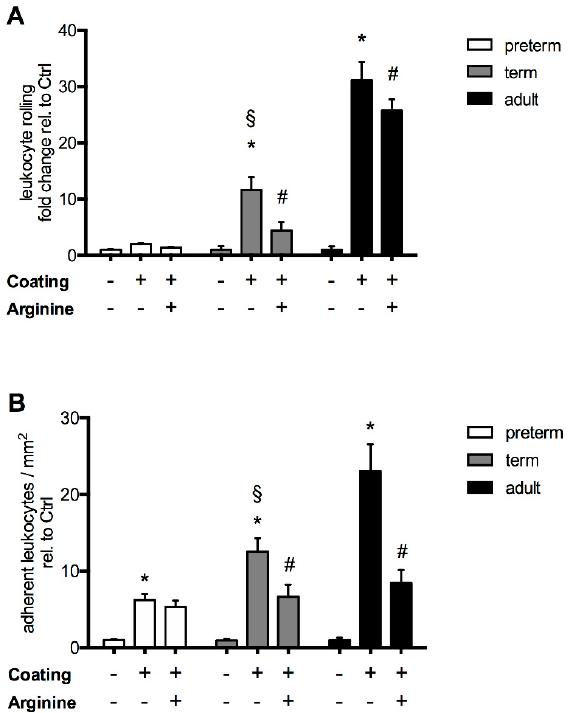
Figure 2. Leukocyte rolling and adhesion is decreased by L-arginine in term infants. Leukocyte rolling ( A ) and adhesion ( B ) of preterm and term infants and adults was analyzed in dynamic microflow chamber experiments. Neutrophil rolling and adhesion upon P-selectin, IL-8, and ICAM-1 coating was compared between the various age groups and to respective uncoated controls or cells that were incubated in 10 µ g / mL L-arginine for 45 min. Results are presented as mean + SEM from at least 5 separate individuals / experiments per group. Statistical analysis was performed by two-way ANOVA and Tukey’s post hoc test. Significance was set at p < 0.05. * indicates significance compared to uncoated controls, # indicates significant downregulation compared to coated chambers, and § indicates significant di ff erences to both preterm and adult coated